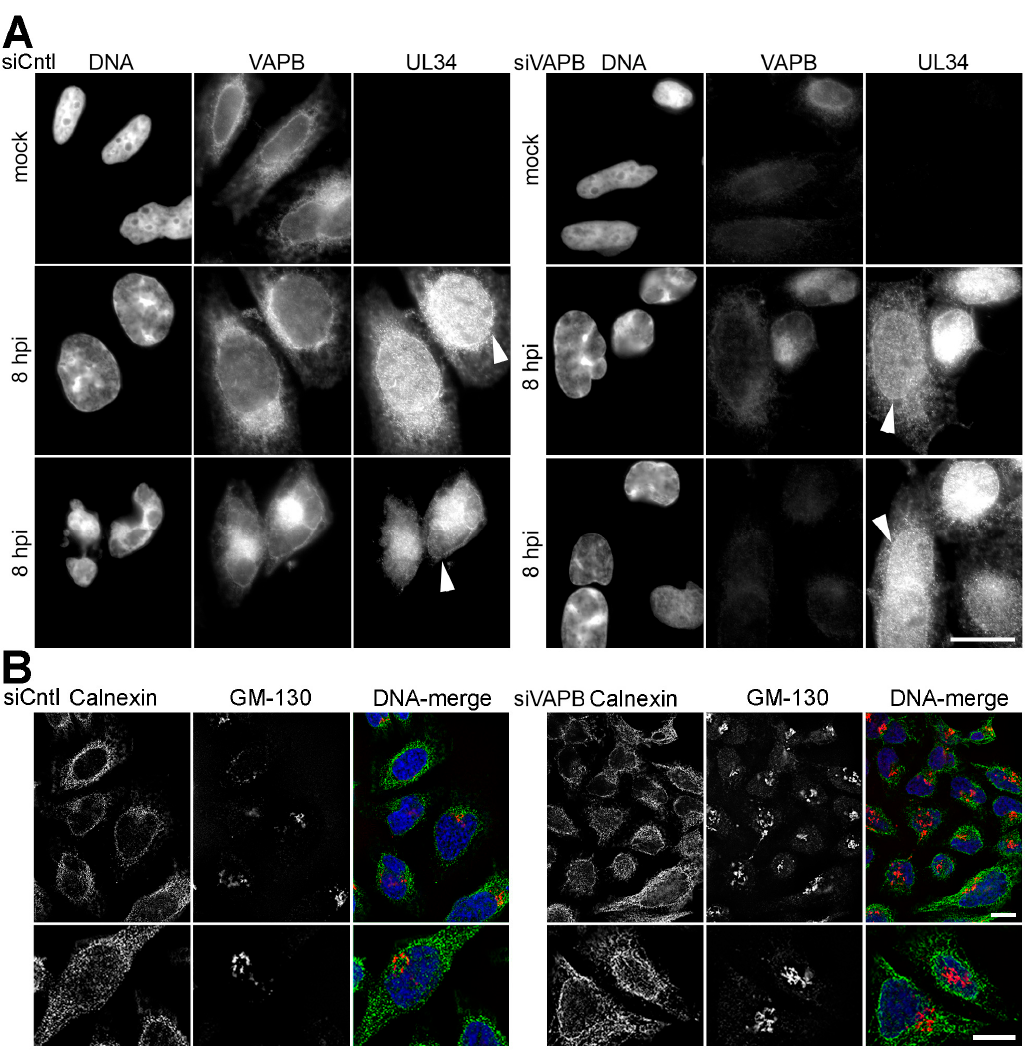
Figure 7. VAPB knockdown neither alters distribution of pUL34 nor notably disrupts other cellular membranes. ( A ) HeLa cells were knocked down for non ‐ target control (Cntl) or VAPB. Cells were stained for confirmation of the knockdown and for pUL34. pUL34 staining could still be observed at the nuclear rim with the VAPB knockdown at 8 hpi. Two separate images are shown to highlight that an increased concentration of staining at the NE (defined as the edge of the DNA staining) is observed in both flatter cells with more normal looking nuclei and more rounded cells with distorted nuclei within the same population. Arrowheads are shown in some cells to indicate the NE. ( B ) Staining Cntl or VAPB knockdown cells for the ER marker calnexin and the Golgi marker GM ‐ 130 revealed no notable differences in staining with VAPB knockdown. Bottom panels are zoomed regions from other images from the same condition. Scale bars, 10